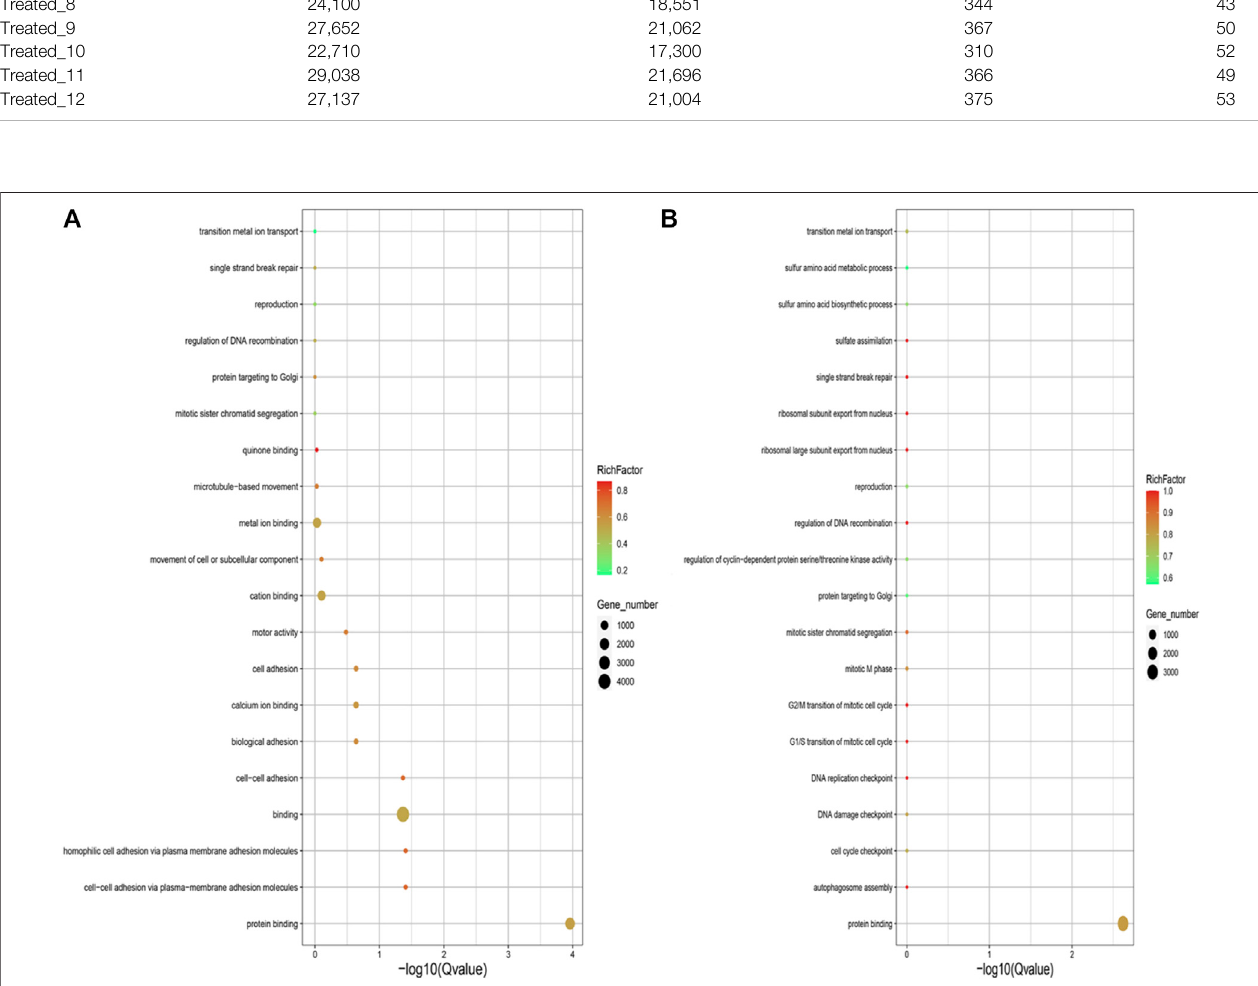
Frontiers in Genetics |